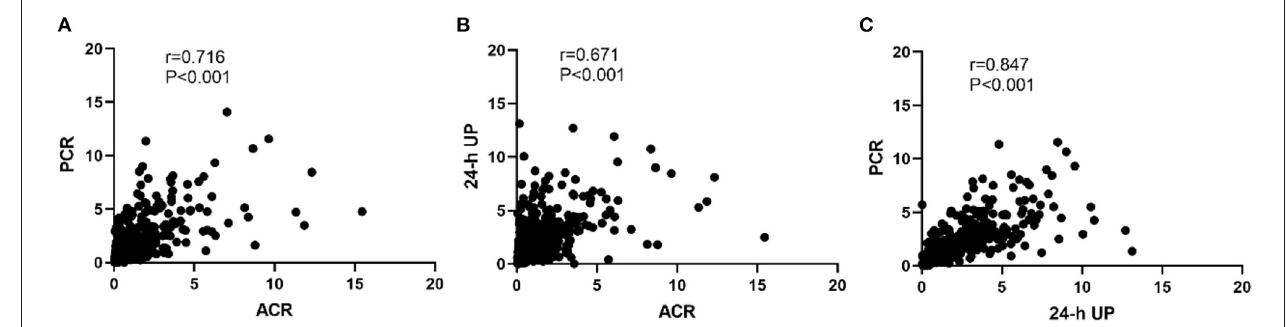
FIGURE 1 | Correlation among PCR, ACR, and 24-h UP. (A) The correlation between PCR and ACR. (B) The correlation between ACR and 24-h UP. (C) The correlation between PCR and 24-h UP. The conversion coefficients between PCR and ACR, 24-h UP and ACR were 0.84 and 0.96, respectively, which means that PCR multiplied by 0.84 equals the value of ACR, and 24-h UP multiplied by 0.96 equals the value of